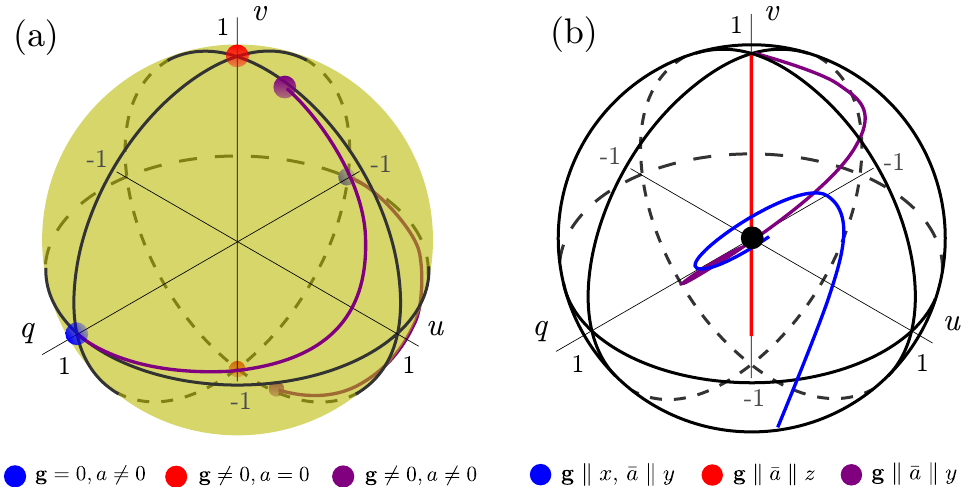
Figure 2. ( a ) Polarization eigenchannels for 3 types of disordered media are shown on the Poincaré sphere. They are depicted by blue dots for the non-magnetic case, g = 0, with possible anisotropy, a (cid:54) = 0, corresponding to the linear polarization. For the magnetic case, g (cid:54) = 0, without anisotropy, a = 0, they are depicted by red dots, corresponding to the circular polarization. For the general case, g (cid:54) = 0, and for a (cid:54) = 0, they are depicted by purple dots, corresponding to the elliptical polarization. The modification of the polarization in the general case by manipulating the gyration is shown by purple lines. ( b ) Normalized Stokes parameters are computed for the electric field correlation matrix, ˜ W ( X ) , for components in the plane that is orthogonal to the gyration direction. Red line shows the oscillation of ˜ W as a function of X for the case g (cid:107) ¯ a (cid:107) z . It is directed along the v -axis, so polarization oscillates between the right and left circularity, being limited to zero for a large value of X (the black dot, full depolarization) . For cases g (cid:107) ¯ a (cid:107) y (purple curve) and g (cid:107) x , ¯ a (cid:107) y (blue curve), symmetric contributions appear in the correlation. The polarizations acquire ellipticity, i.e., all Stokes parameters obtain non-zero values. (We assume that the direction of light propagation is parallel to the magnetization. | g | = 0.2, a =